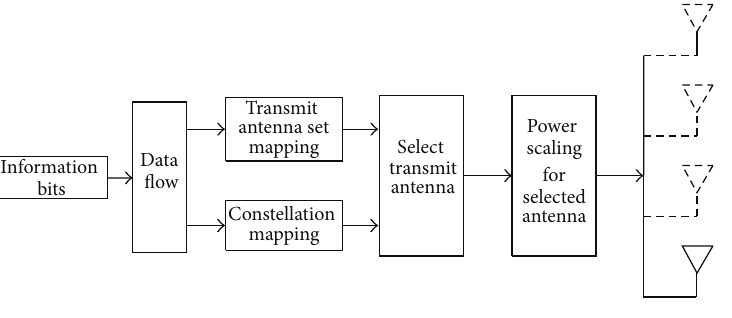
Figure 1: Block diagram of proposed power scaling SM-MIMO system.